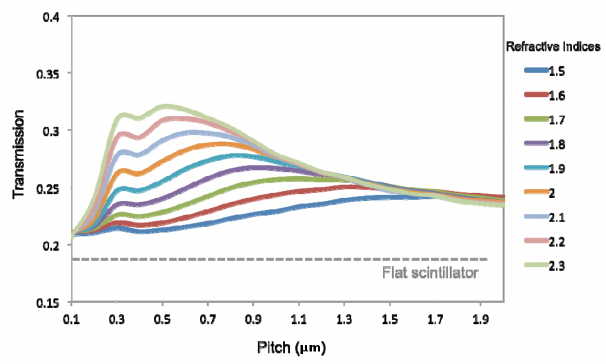
Figure 22. Transmission efficiency of the PhC slab as a function of the periodicity. Different curves are shown representing different RI of the slab Section 8.3,